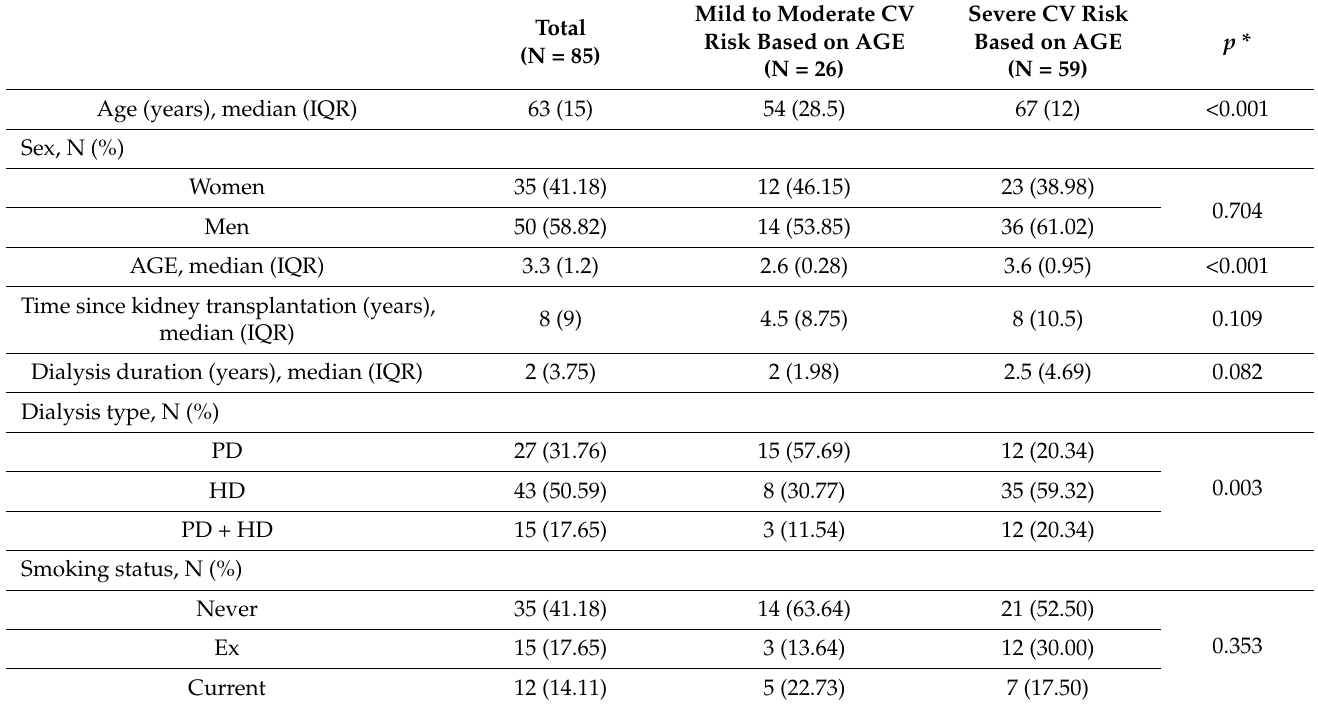
Table 1. General characteristics of study participants and differences according to cardiovascular risk classification.